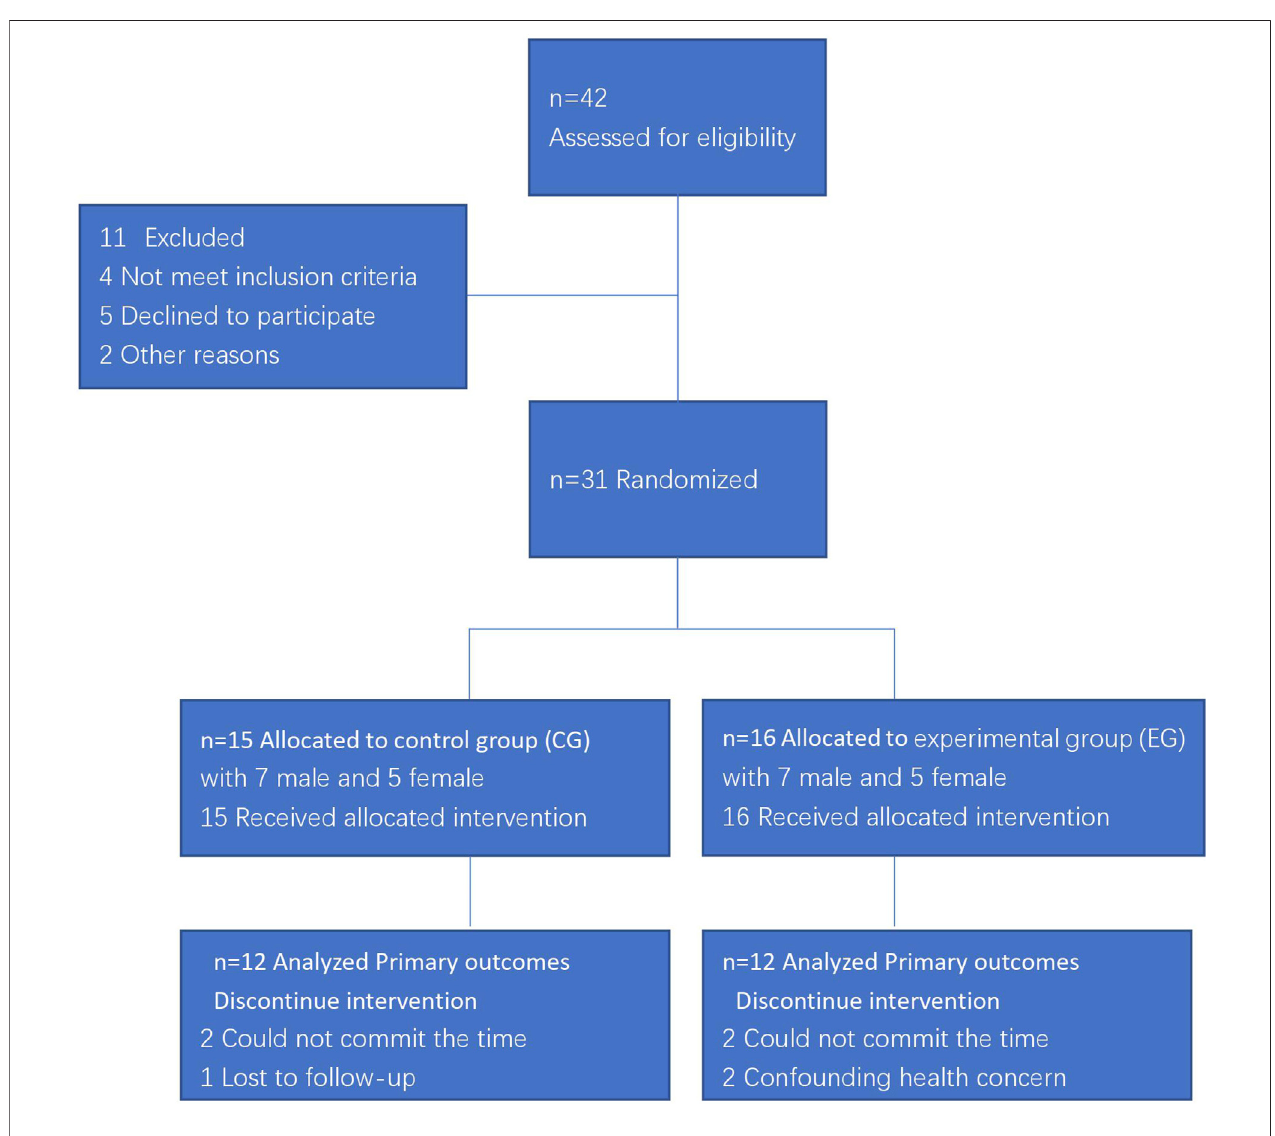
FIGURE 2 | The fl ow diagram of